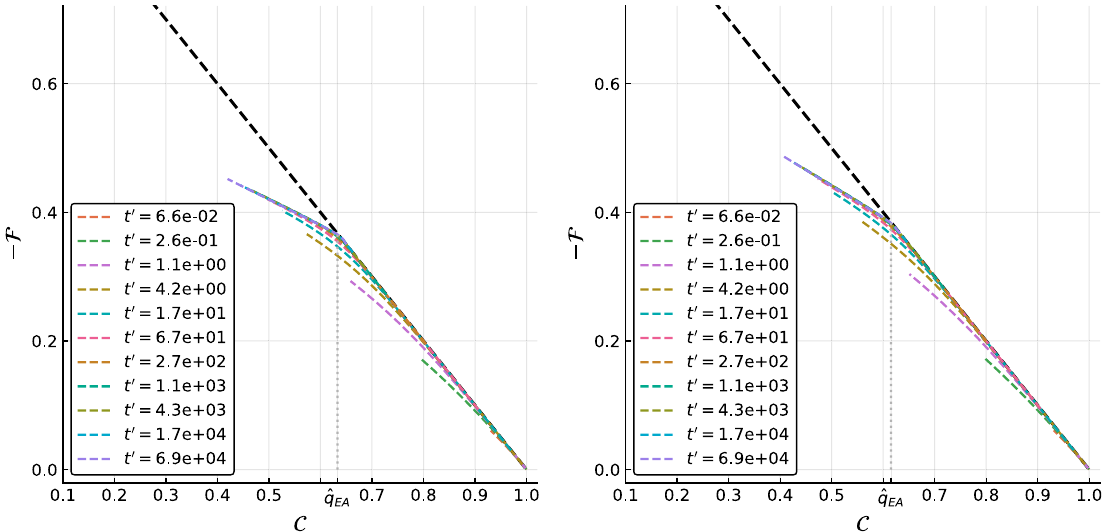
FIG. 22. Left panel: Parametric plot of the integrated response function with respect to the correlation function for p ¼ 3 , Δ 2 ¼ 0 . 8 , 0 . 2 . The different lines represent different waiting times, t 0 . The black dashed line corresponds to the FDT prediction x ¼ 1 . and Δ p ¼ and should be equal to the saddle-point value The vertical dotted line is the point where we observe a kink, which we denote by C ¼ ˆ q EA 0 . 633 and q 0 . 638 . For C smaller than of q as extracted from the 1RSB threshold states in the replica computation [27]: ˆ q M EA ¼ M ¼ q , the FDT is violated and is replaced by a generalized version as in Eq. (E10). We can obtain the value of the FDT ratio from a fit of EA the slope of the asymptotic curves for C < ˆ q . We obtain ˆ x ¼ 0 . 397 , which should be compared with the Parisi parameter that EA corresponds to 1RSB marginally stable states obtained from the replica computation, that is, x ¼ 0 . 408 . Right panel: Parametric plot of 0 . 2 . In this case, the value of the FDT ratio the integrated response as a function of the correlation for p ¼ 3 and Δ 2 ¼ 1 . 4 and Δ p ¼ extracted from fitting the data is ˆ x ¼ 0 . 397 , to be compared with the value of the Parisi parameter for the 1RSB threshold states, that is, 0 . 633 , while the replica computation gives q 0 . 638 x ¼ 0 . 408 . At the same time, data give ˆ q EA ¼ M ¼